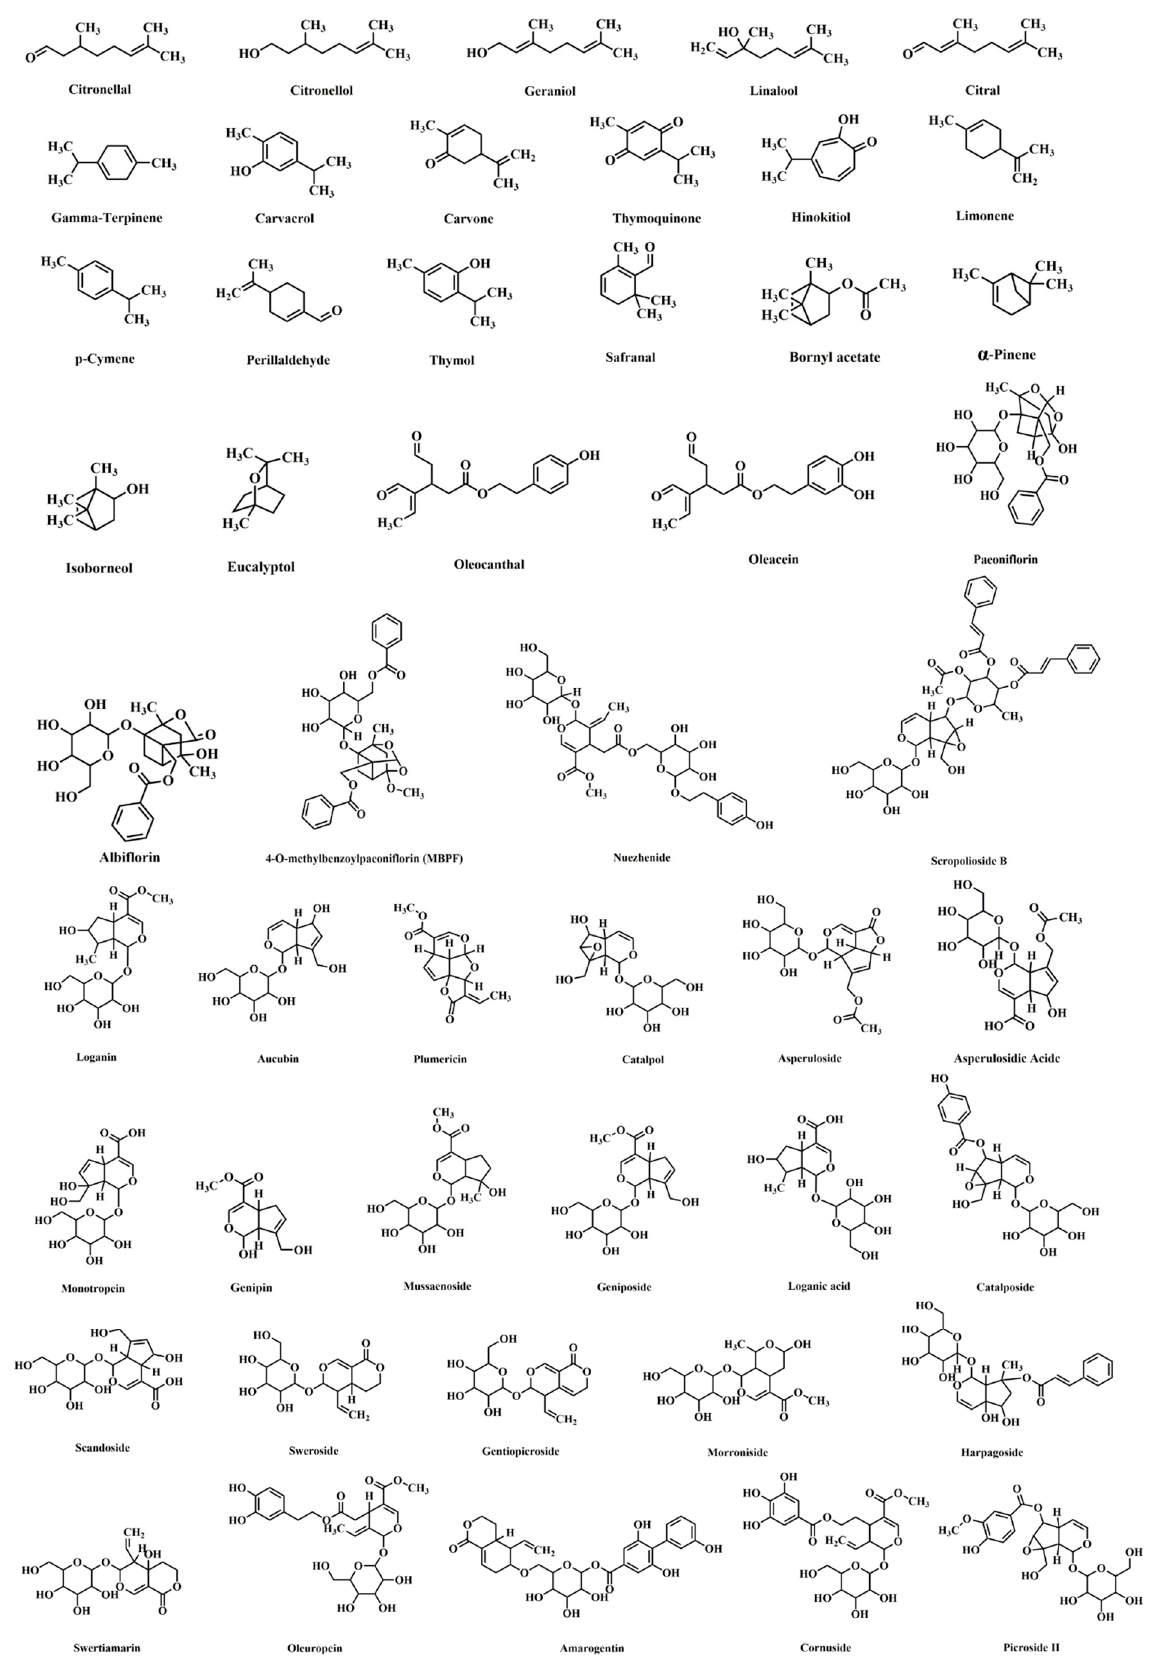
Figure 1. Chemical structures of natural monoterpenes with potential antiatherogenic effects.